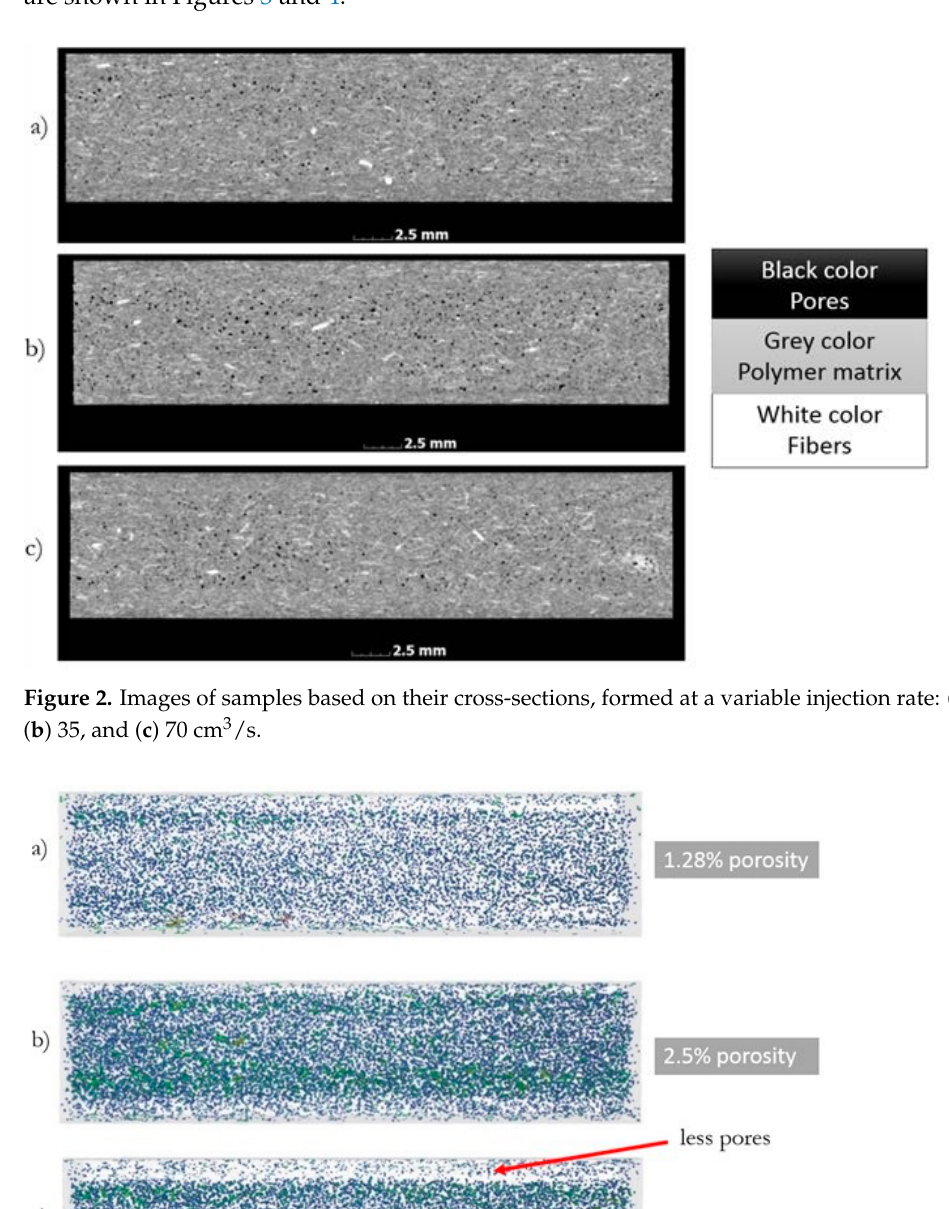
Figure 3. The results of the porosity analysis for injected samples at a variable injection rate: ( a ) 10, ( b ) 35, and ( c ) 70 cm 3 /s—digital reconstruction.